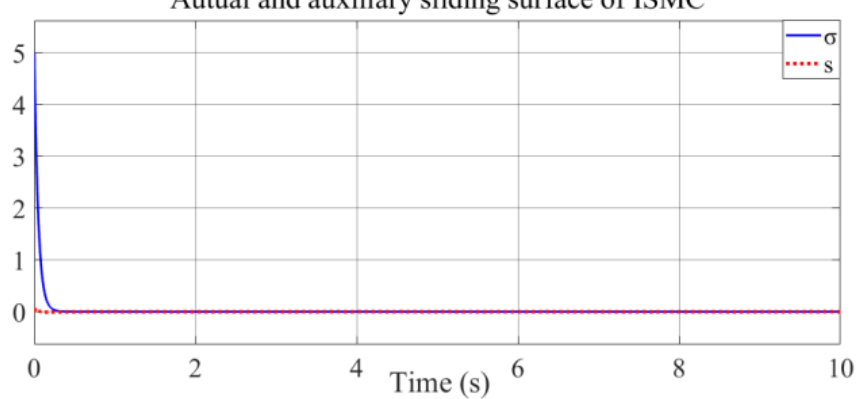
Figure 10. 𝜎 converges to zero in finite time, s remains (starts from zero) at zero (ISMC).